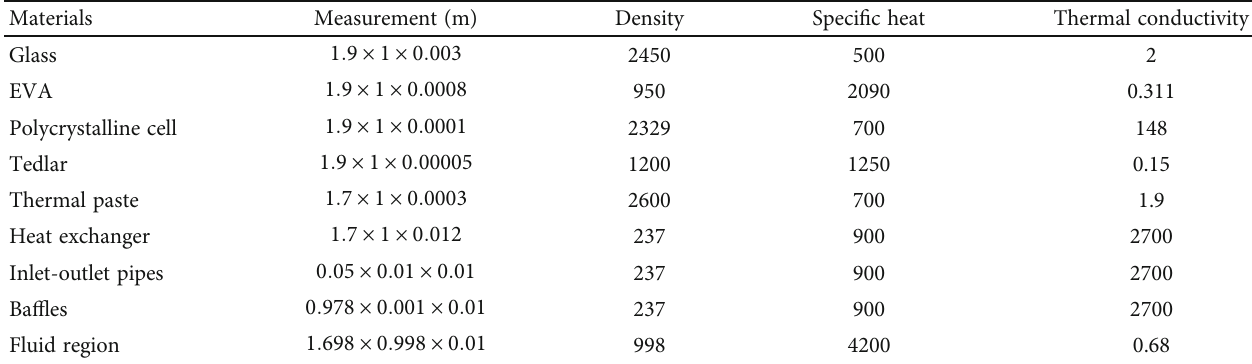
Table 1: The measurements and material criteria of the PVT [3, 8, 9].